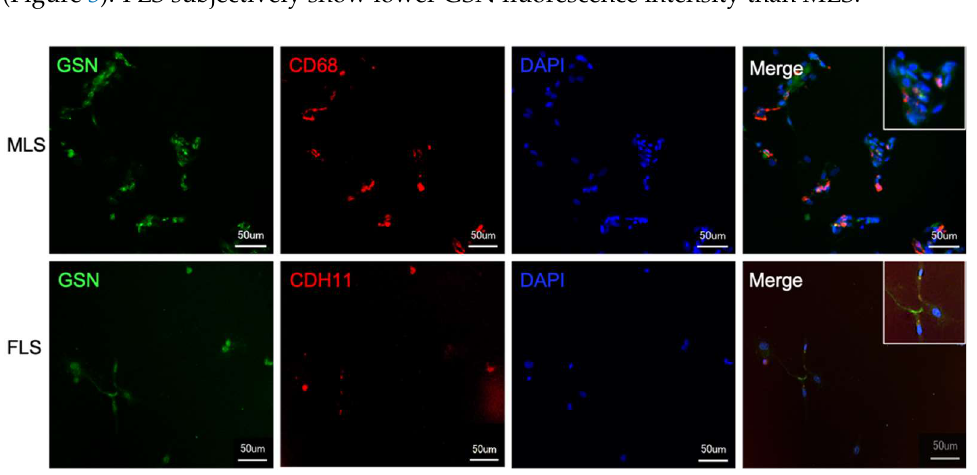
Figure 3. Isolated MLS and FLS producing gelsolin. Isolated and cultured macrophage-like synoviocytes (MLS) and fibroblast-like synoviocytes (FLS) show a positive antibody response for cell-specific markers (MLS = CD68 (red); FLS = CDH11 (red)) and for gelsolin (GSN—green) by immunofluorescence.